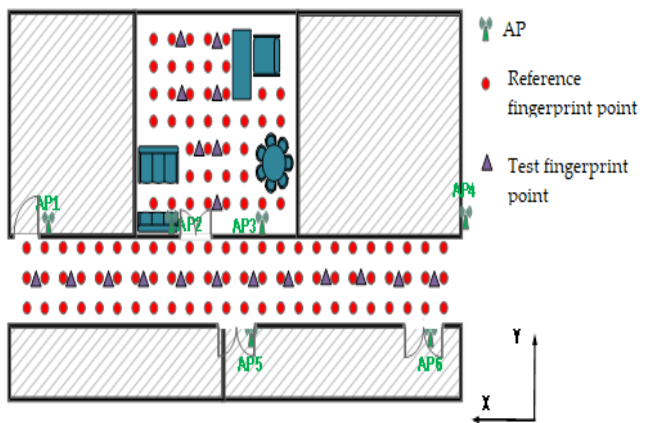
Figure 9. Distribution of test fingerprint